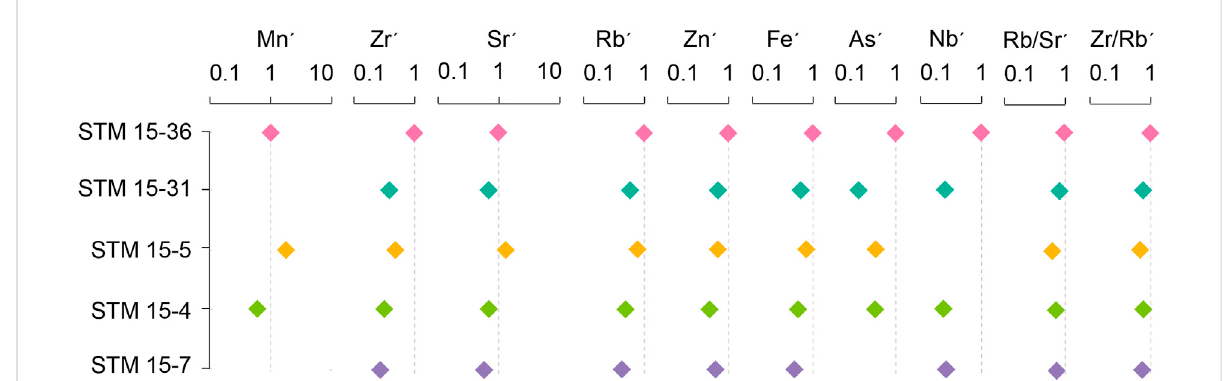
Elemental indices standardized according to those of Sapeornis STM 15-36 ’ s host sediments.